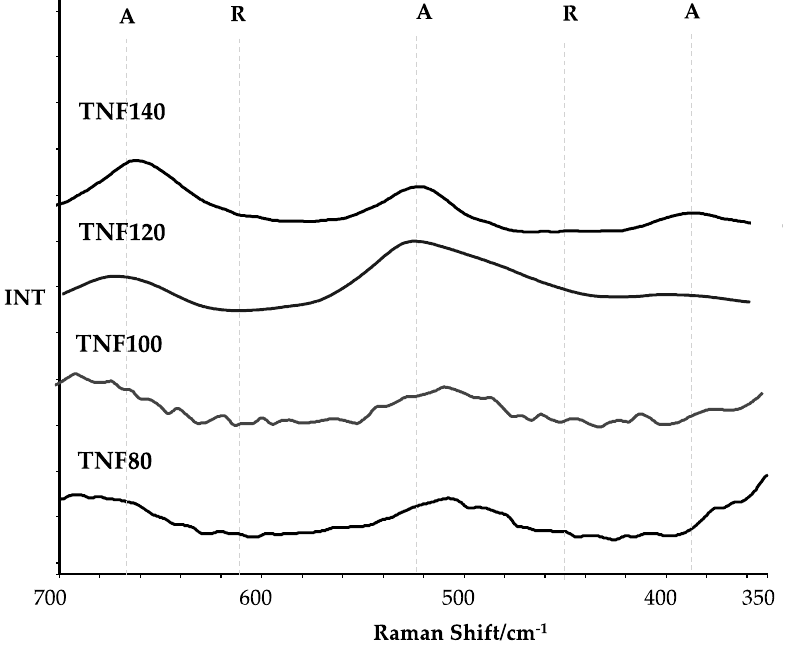
Figure 4. Raman spectra of titania nanofibers (TNFs).